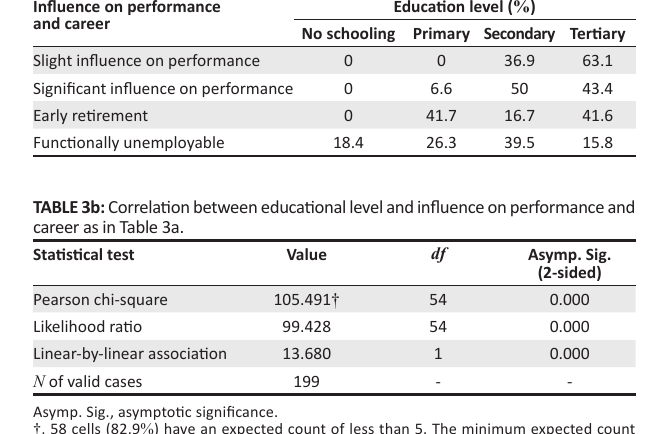
TABLE 3a: Cross tabulation of education level and the influence of motor vehicle accidents on the performance and careers of victims. Influence on performance and career